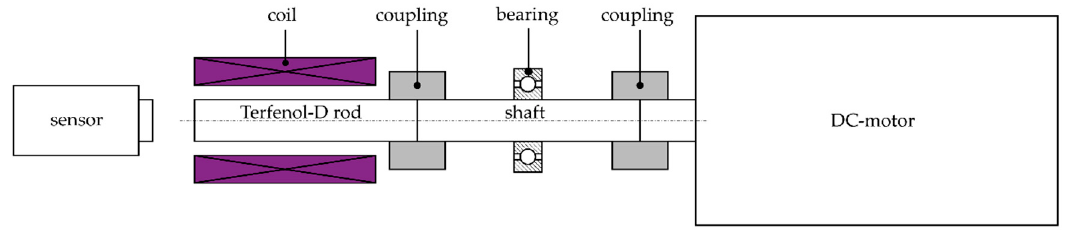
Figure 4. System design of the test stand.